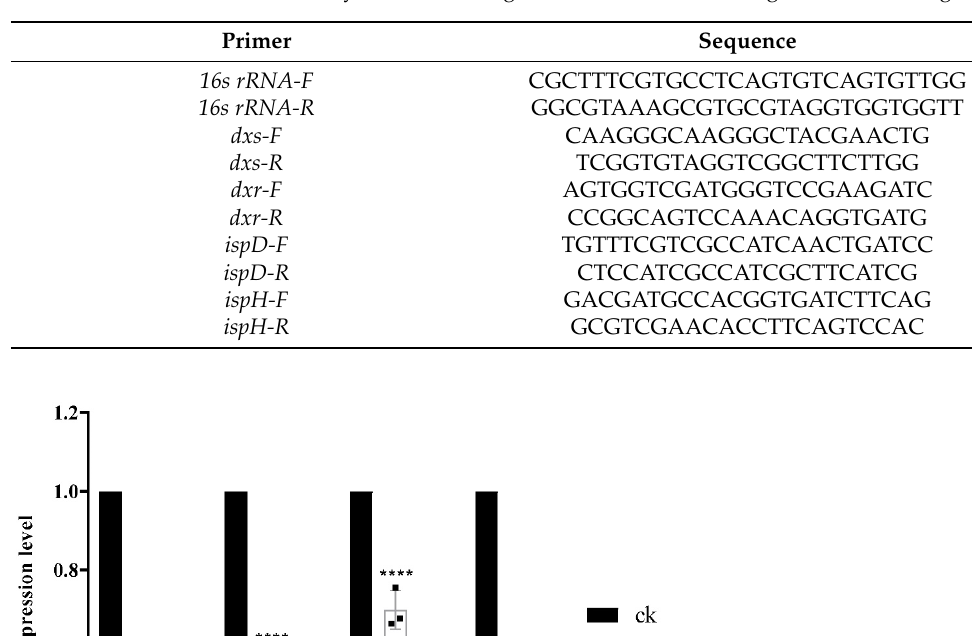
Table 3 . Primers used in this study; the 16s rRNA gene was used as the endogenous reference gene.